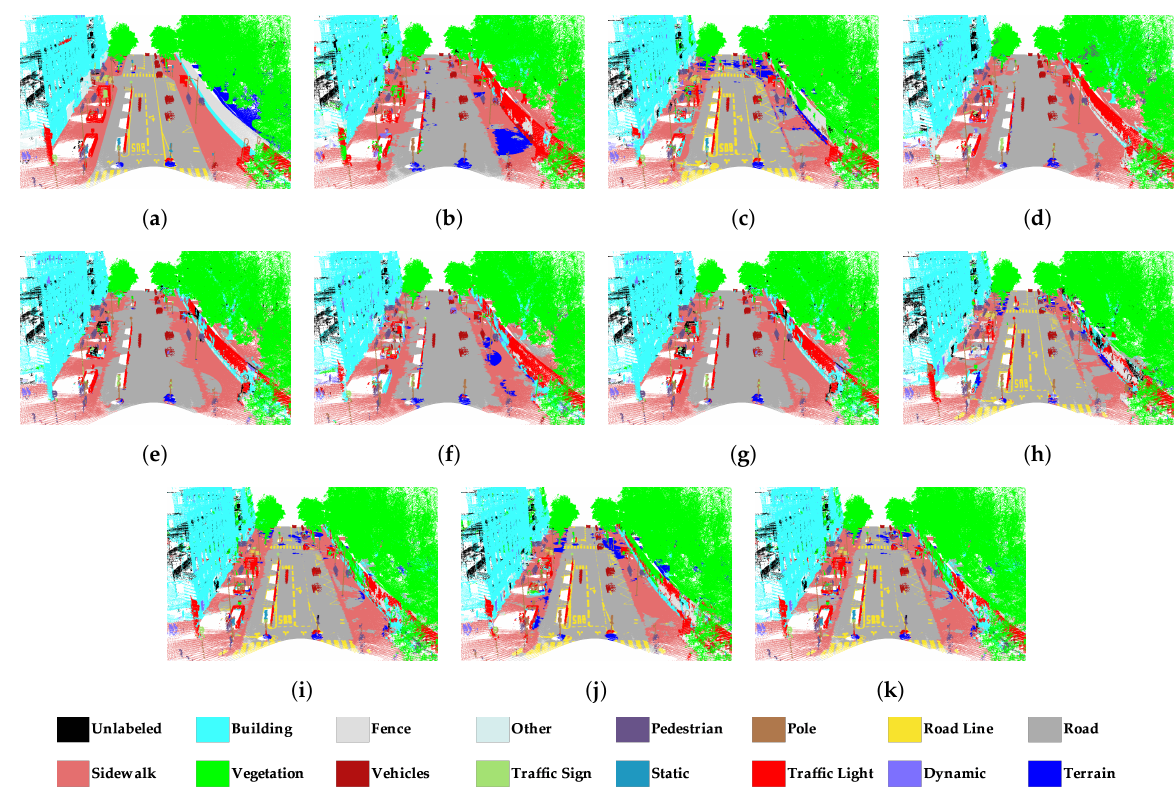
Figure 9. Qualitative results of the methods for Paris dataset with RandLA-Net. ( a ) Ground Truth;